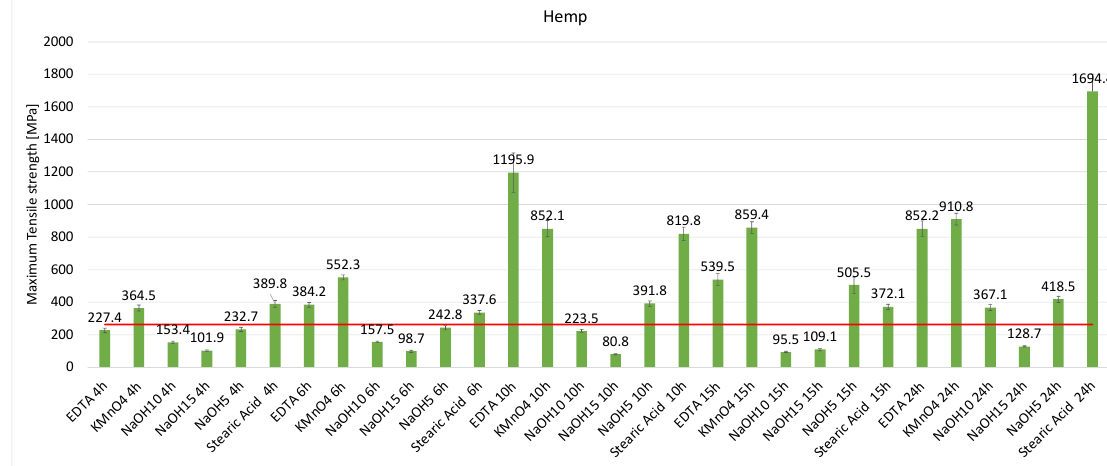
Figure 10. Maximum tensile strength obtained for each treatment on hemp fibres.